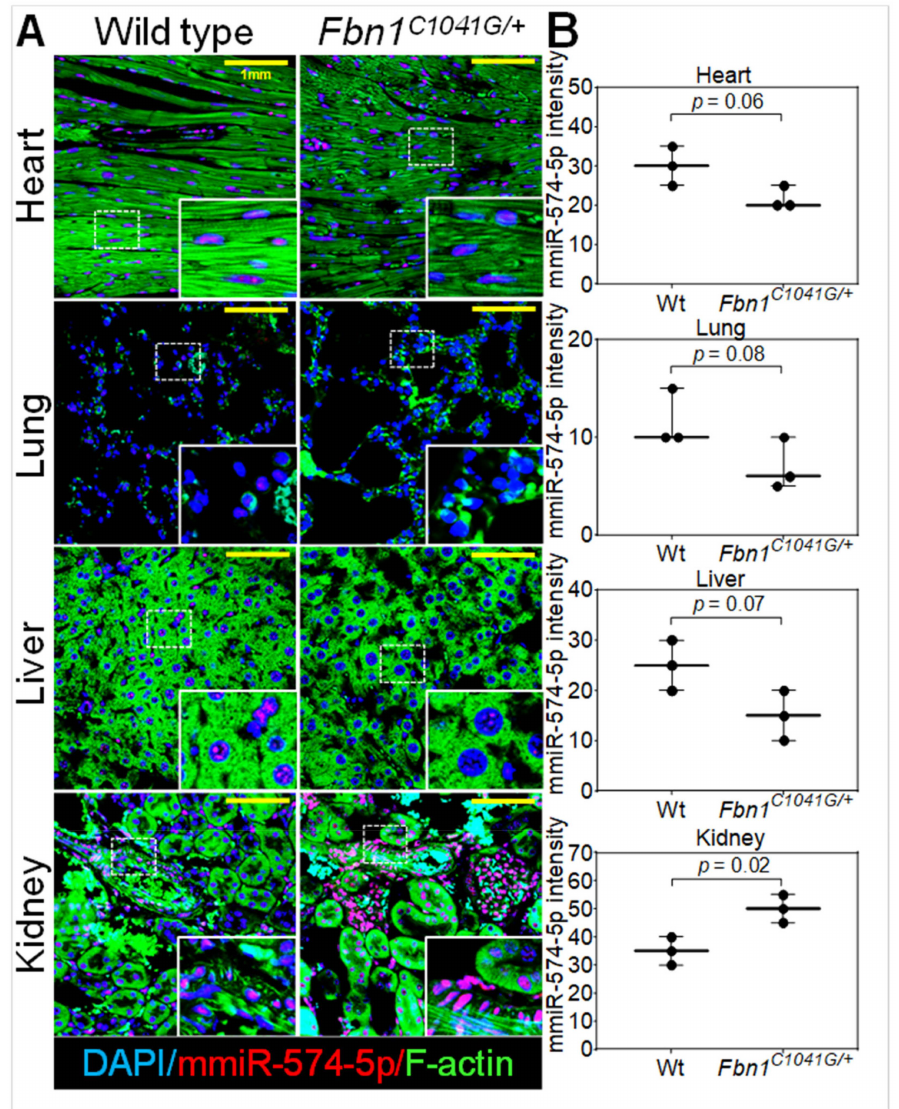
Figure 4. Expression of miR-574-5p in di ff erent organs (heart, lung, liver and kidney) in the wild-type (Wt) and Fbn1 C1041G /+ mice. ( A ) Immunofluorescence and Fluorescence in situ hybridization (FISH) of miR-574-5p (red), F-actin (green) and nucleus (blue) from Wt and Fbn1 C1041G /+ mice. ( B ) Relative fluorescence intensity quantification from Wt ( n = 3, two males and one female) and Fbn1 C1041G /+ ( n = 3, one male and two females) mice. The yellow scale bar corresponds to 1